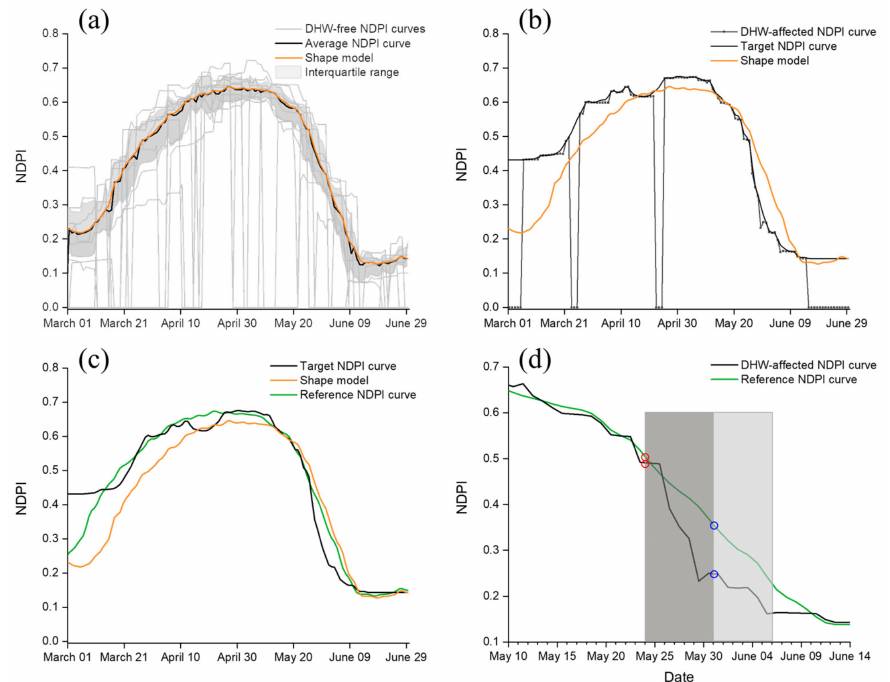
Figure 4. The shape model fitting method to generate the reference NDPI curve (DHW in legend represents dry-hot wind). ( a ) illustrates how the shape model is generated using the multiyear NDPI curves. Interquartile range is represented by light gray-shaded areas in ( a ); ( b ) shows the difference between the shape model and the target NDPI curve; ( c ) shows the process of generating the reference NDPI curve using shape model fitting method; ( d ) illustrates how to determine the NDPI values before and after the occurrence of dry-hot wind from the dry-hot wind affected NDPI curve and the reference NDPI curve. Dark gray box in ( d ) represents the duration of dry-hot wind episode and light gray box represents 6 days after the end of the dry-hot wind